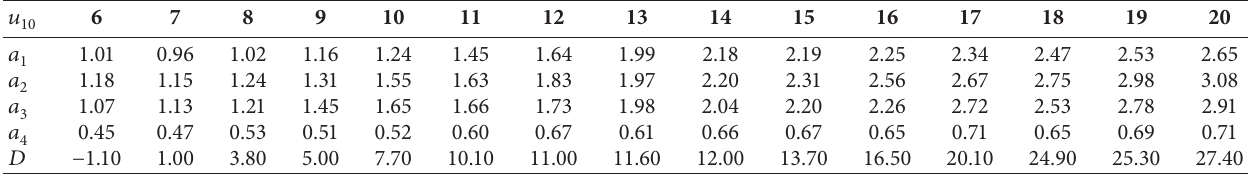
Table 4: Standardized statistical results of characteristic parameters calculated by TSM for freak waves at different wind speeds.